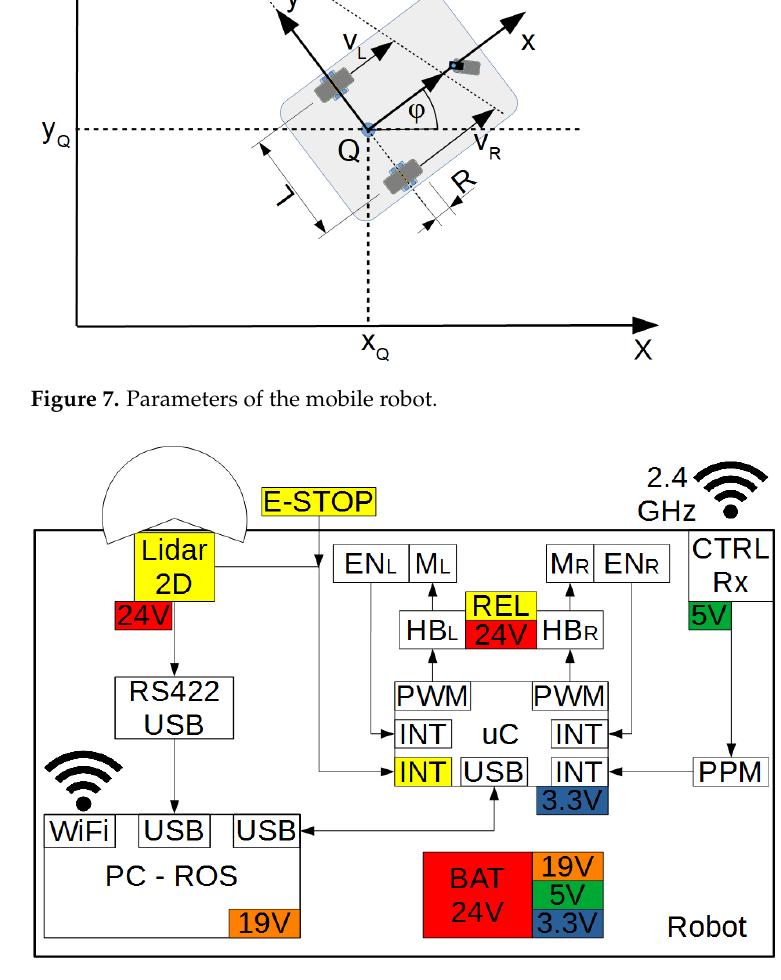
Figure 8. Control system of the mobile